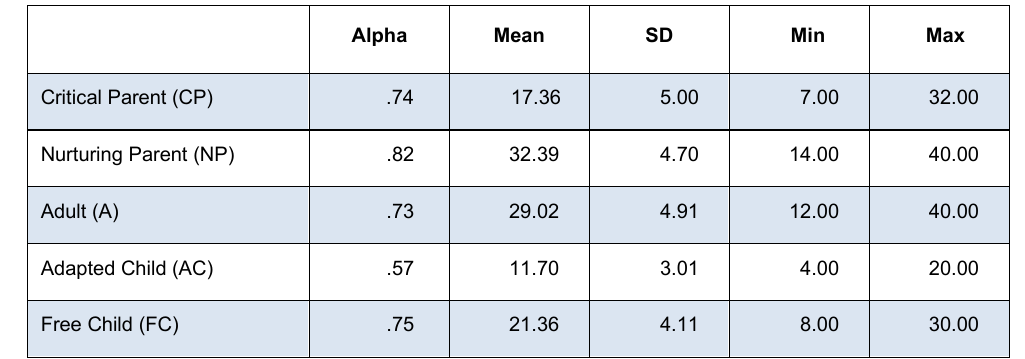
Table 2: Rotated factor loadings of the Ego State Questionnaire- Revised dimensions and Cronbach’s alpha coefficients for the five dimensions (N = 483)